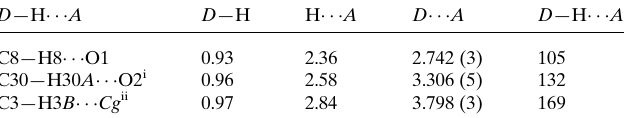
Table 2 Hydrogen-bond geometry (A˚ , (cid:3) ) for (II). Cg is the centroid of the C9–C14 ring.